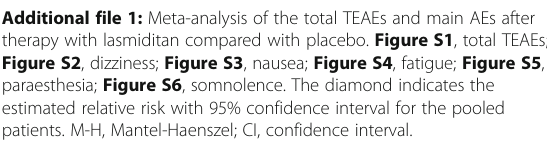
Figure S2 , dizziness; Figure S3 , nausea; Figure S4 , fatigue; Figure S5 , paraesthesia; Figure S6 , somnolence. The diamond indicates